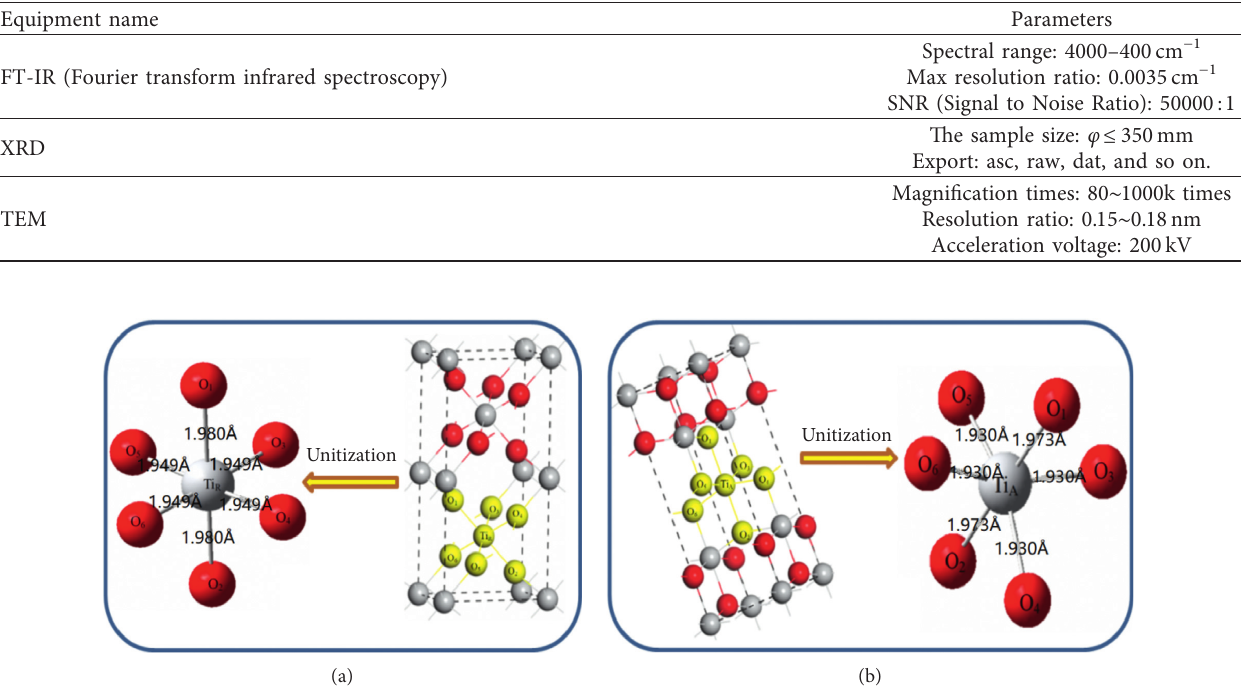
Table 1: Instrument parameters.